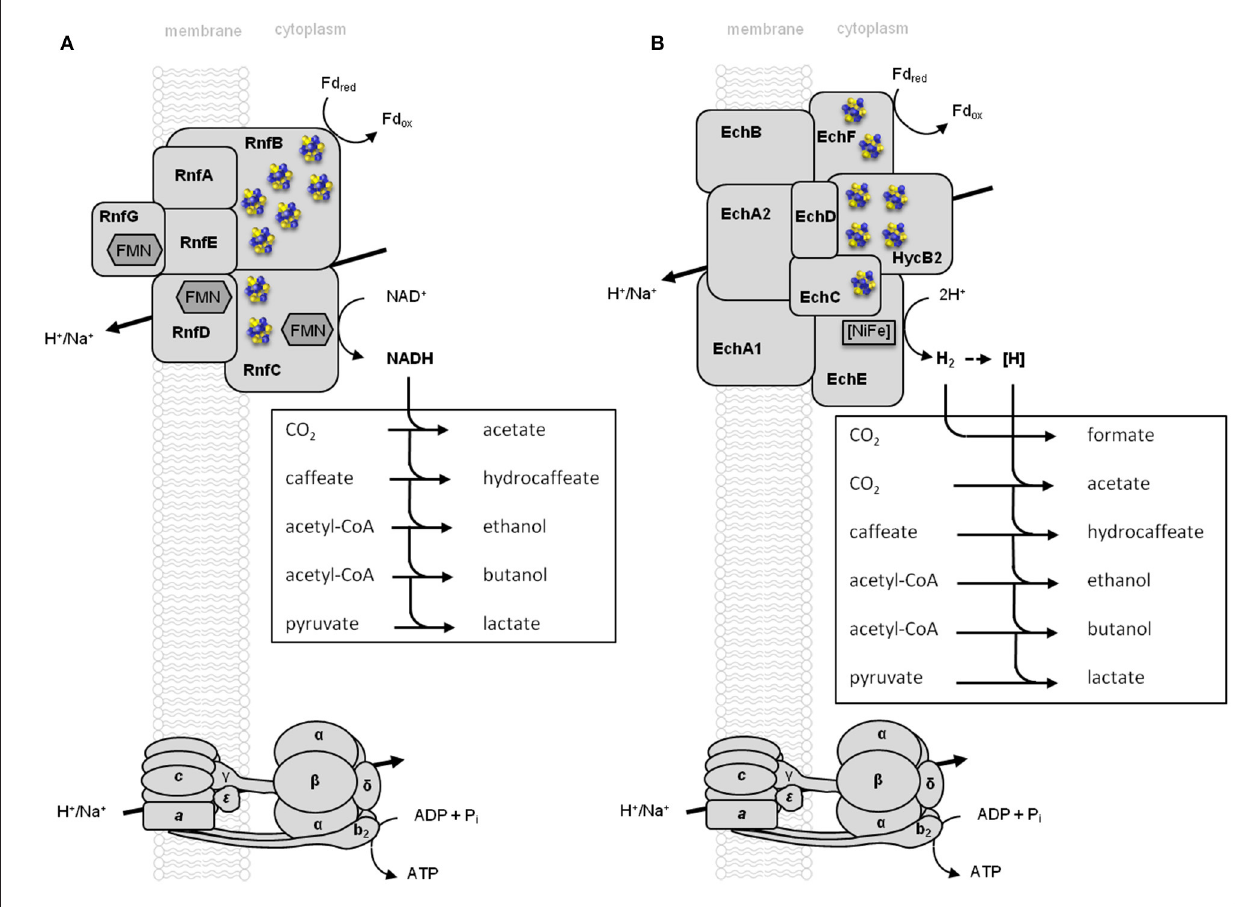
FIGURE 2 | Respiratory enzyme complexes Rnf and Ech in acetogens. Acetogens are classified in Rnf- (A) or Ech-containing (B) organisms. Exergonic electron transfer leads to the translocation of H + /Na + across the cytoplasmic membrane and the electrochemical H + /Na + potential is then the driving force for ATP synthesis. Reducing equivalents are oxidized via different pathways, results in different product formations. Rnf, model of A. woodii ; Ech, model of T. kivui ; [H], reducing equivalents; FMN, flavin mononucleotide.